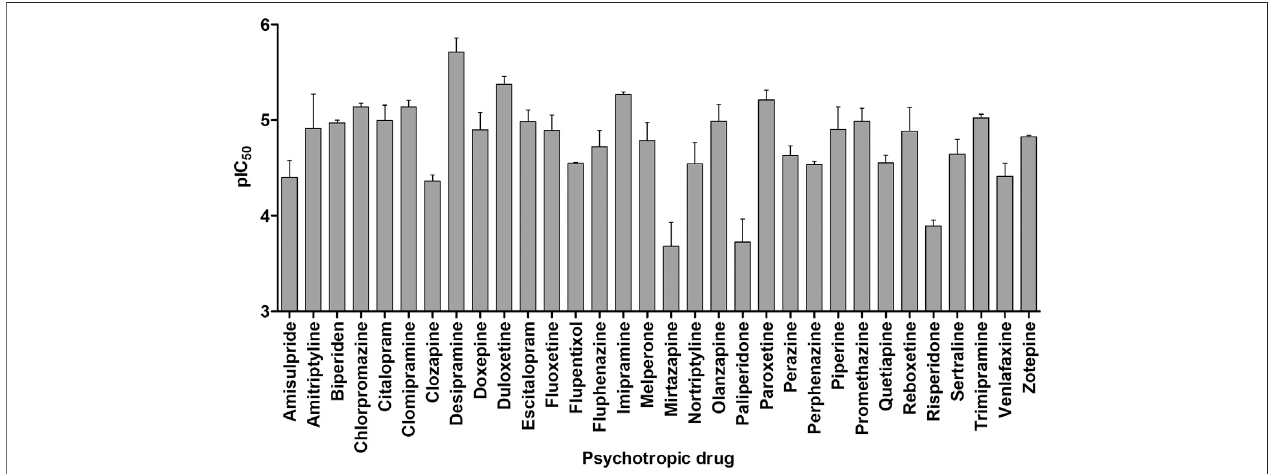
FIGURE 2 | In vitro assessment of OCT1 inhibition by a range of different antidepressant and neuroleptic drugs. Shown is the mean negative logarithm of the IC 50 values of 3 – 4 independent experiments, the error bars indicate the SEM.